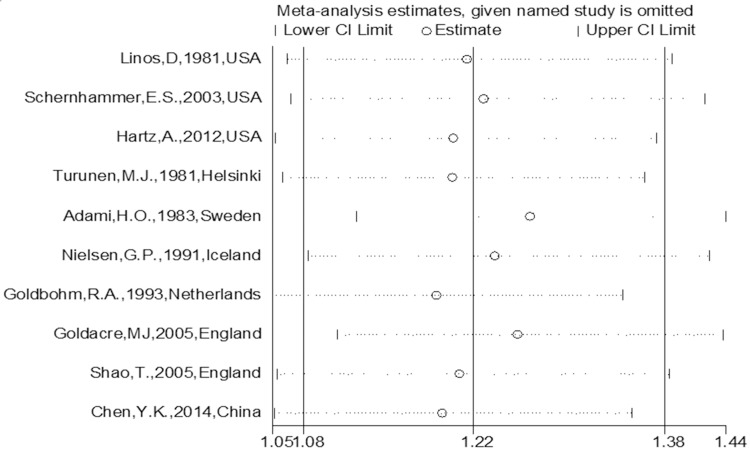
Sensitivity analysis of the association between cholecystectomy and CRC risk in general population.Note: CRC represents colorectal cancer.